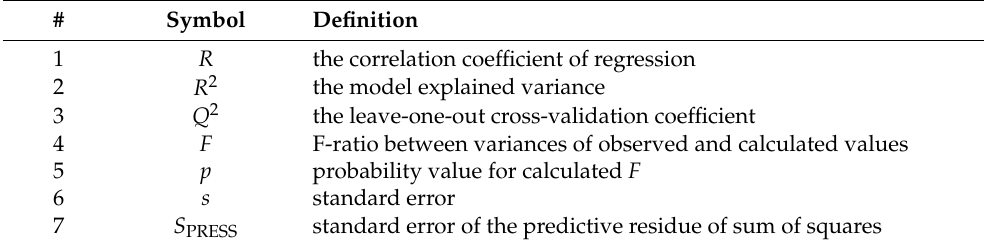
Table 3. Definitions of descriptors included in five-variable model for the prediction of the K